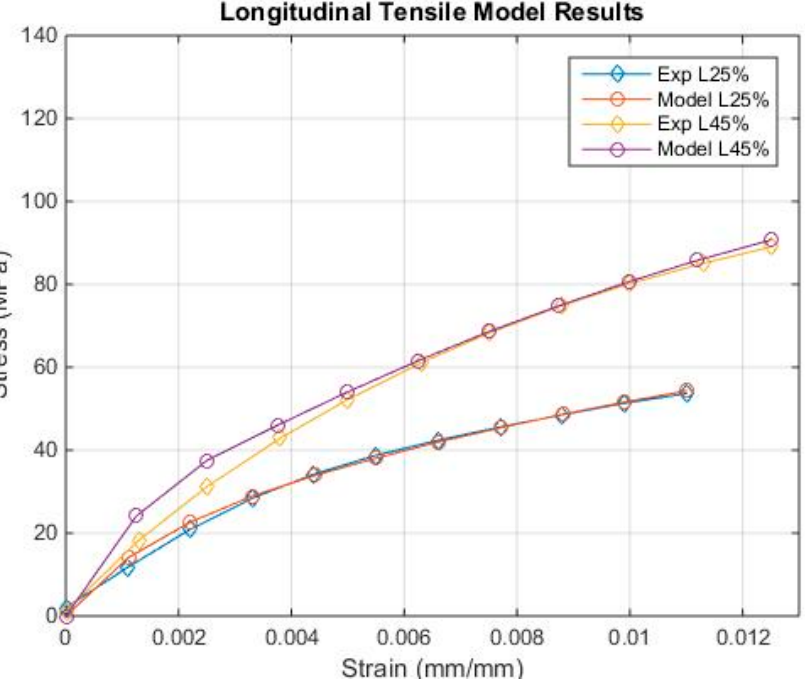
Figure 10. Uniaxial tension experimental and simulated stress–strain curves for the longitudinal direction.